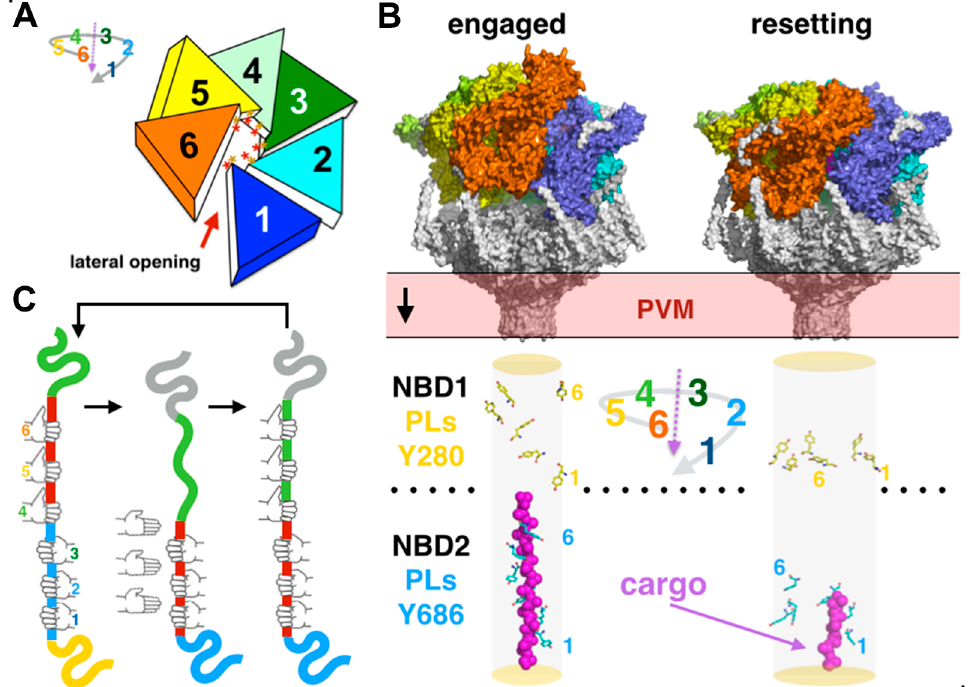
Figure 6. Spiral staircase hexameric assembly and substrate translocation in HSP101. ( A ) Schematic of the splayed spiral staircase assembly of HSP101. Each ATPase monomer is colored differently. ( B ) The two conformational states of PTEX resolved by cryo-EM with the conformations adopted by each of the twelve conserved pore loop tyrosines; the observed unfolded cargo is shown as magenta spheres. ( C ) Schematic representation of a cargo threading cycle in the NBD2 of HSP101. Each hand represents a pore loop in the NBD2. The ‘active hand’ pore loops 4–6 move up and down the ATPase translocation pore and thread it to the ‘static hand’ pore loops 1–3.